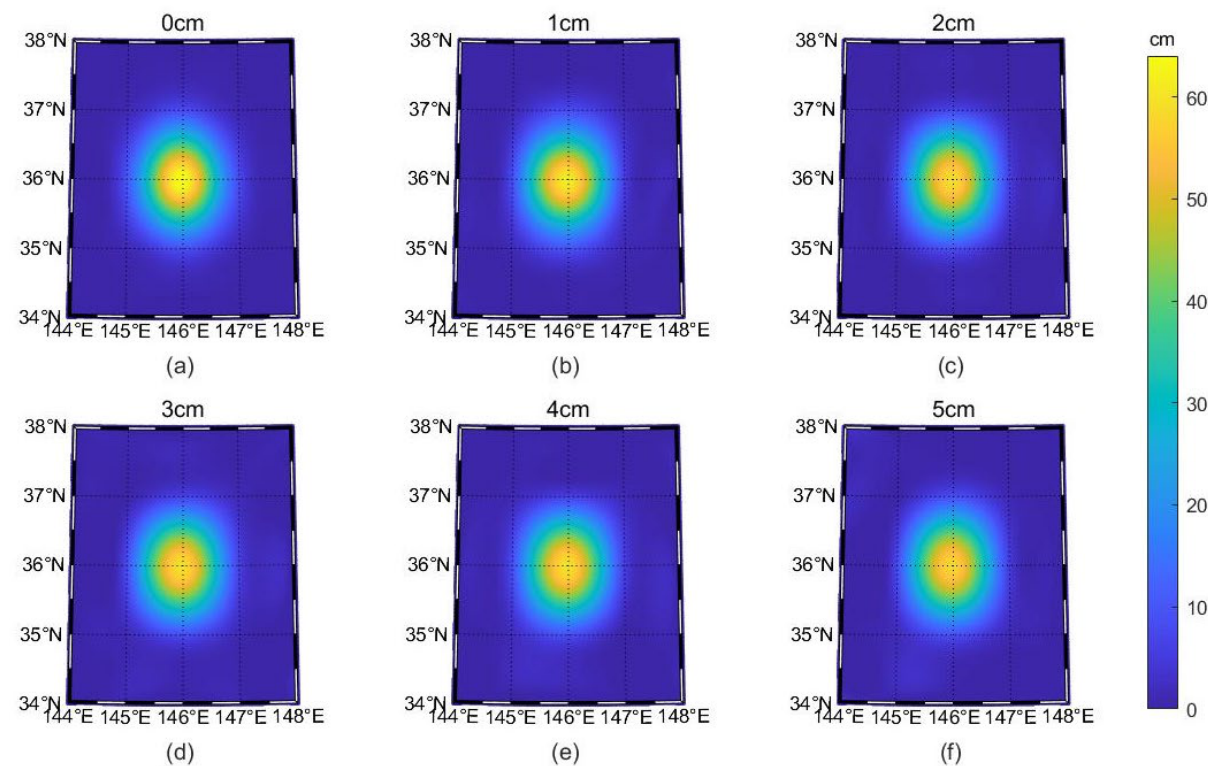
Figure 8. The results of the B-spline fitting with different levels of random noise. ( a ) No noise is introduced. ( b – f ) 1–5 cm of noise is introduced, respectively.